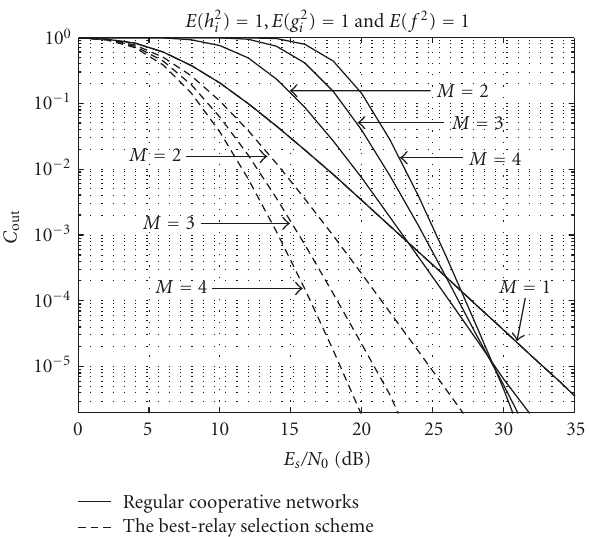
Figure 5: Comparison between the regular cooperative diversity and the best-relay selection scheme over Rayleigh fading channels. (Note that for M = 1, the regular cooperative diversity and best- relay selection scheme are the same.)